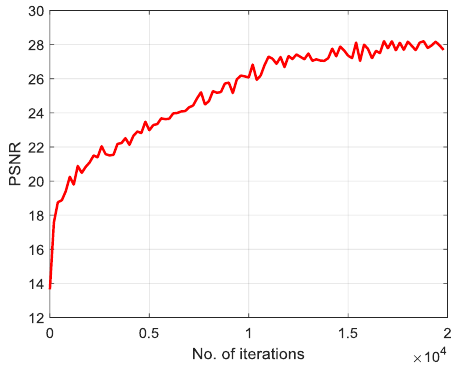
Figure 9. The PSNR of the reconstructed SAR image.